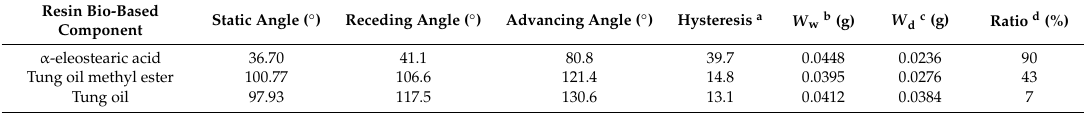
Table 1. Static and dynamic contact angles, and water absorption measurements of fully-cured resins. Resin Bio-Based Component